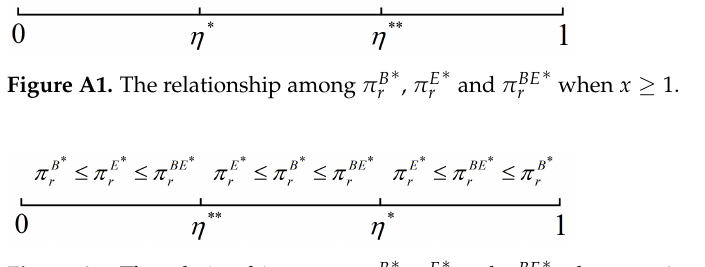
Figure A2. The relationship among π B r